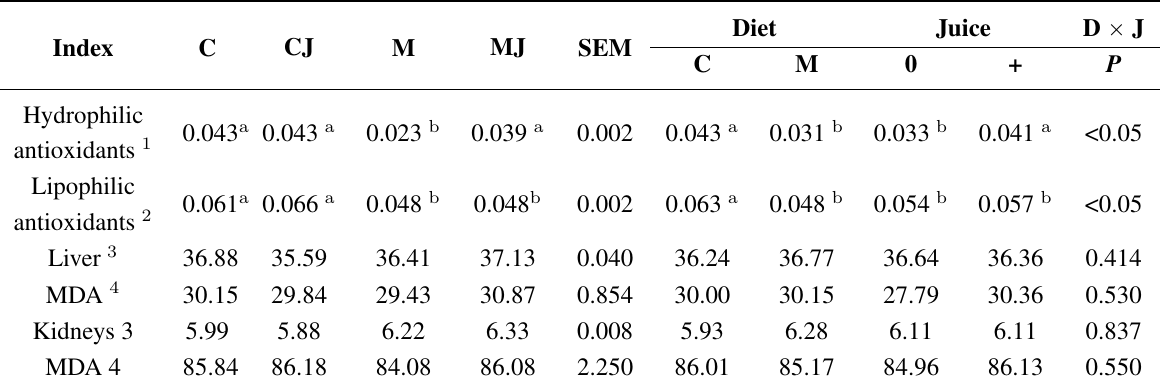
Table 4. Antioxidant status of serum, liver and kidney of rats fed with alkylating agents (mutagen) MNU and fermented beetroot